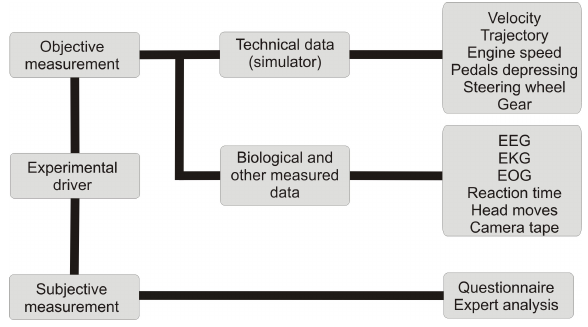
Figure 1. Hierarchical structure of measured